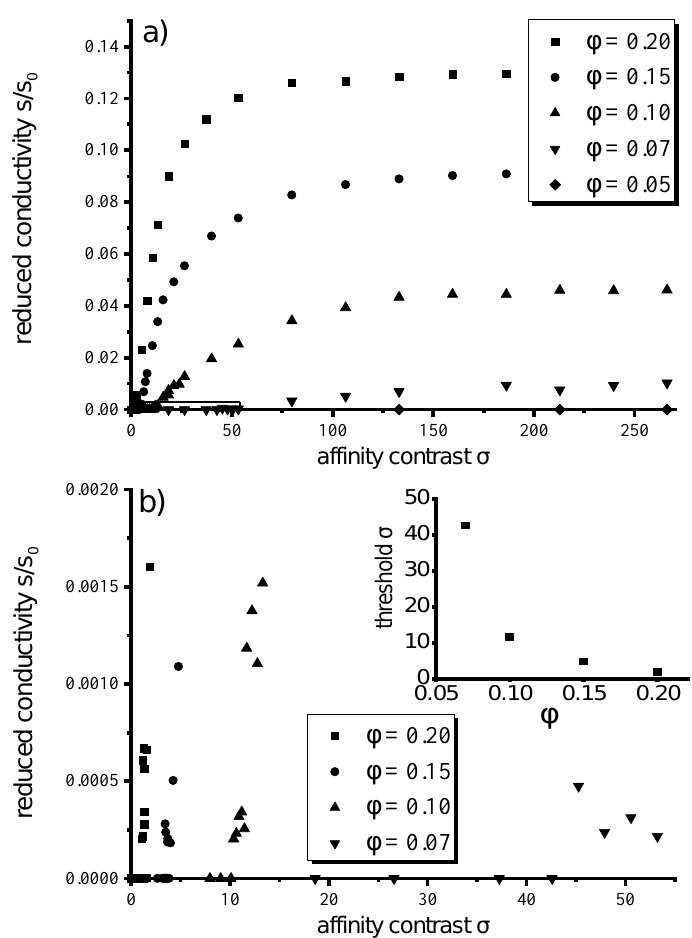
Figure 3. ( a ) Effect of the contrast between affinities of the fillers for dissimilar copolymer blocks quantified by σ on the conductivity of the DBC composite for several selected volume fractions φ of the fillers. The interaction between fillers is set equal to kT . ( b ) Zoom of the highlighted portion of Figure ( a ) in the upper panel. The inset shows the threshold values of σ delineating the conductive and insulating states of the